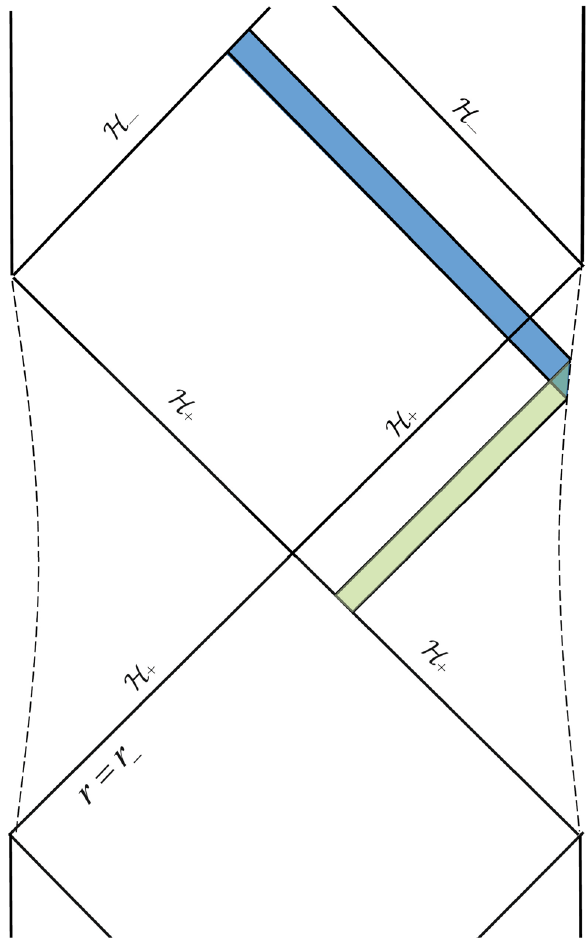
Fig. 1 Wheeler–DeWitt patch at late time of a multiple Killing hori- zon black hole, where the dashed lines denote the cut-off surface at asymptotic infinity, satisfying the asymptotic